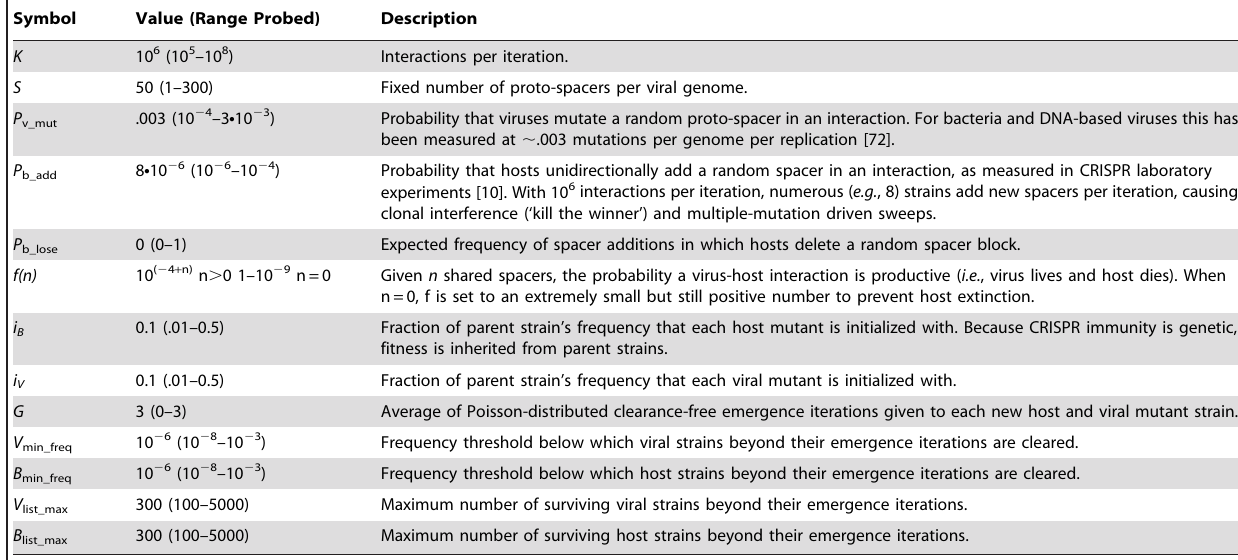
Symbol Value (Range Probed)